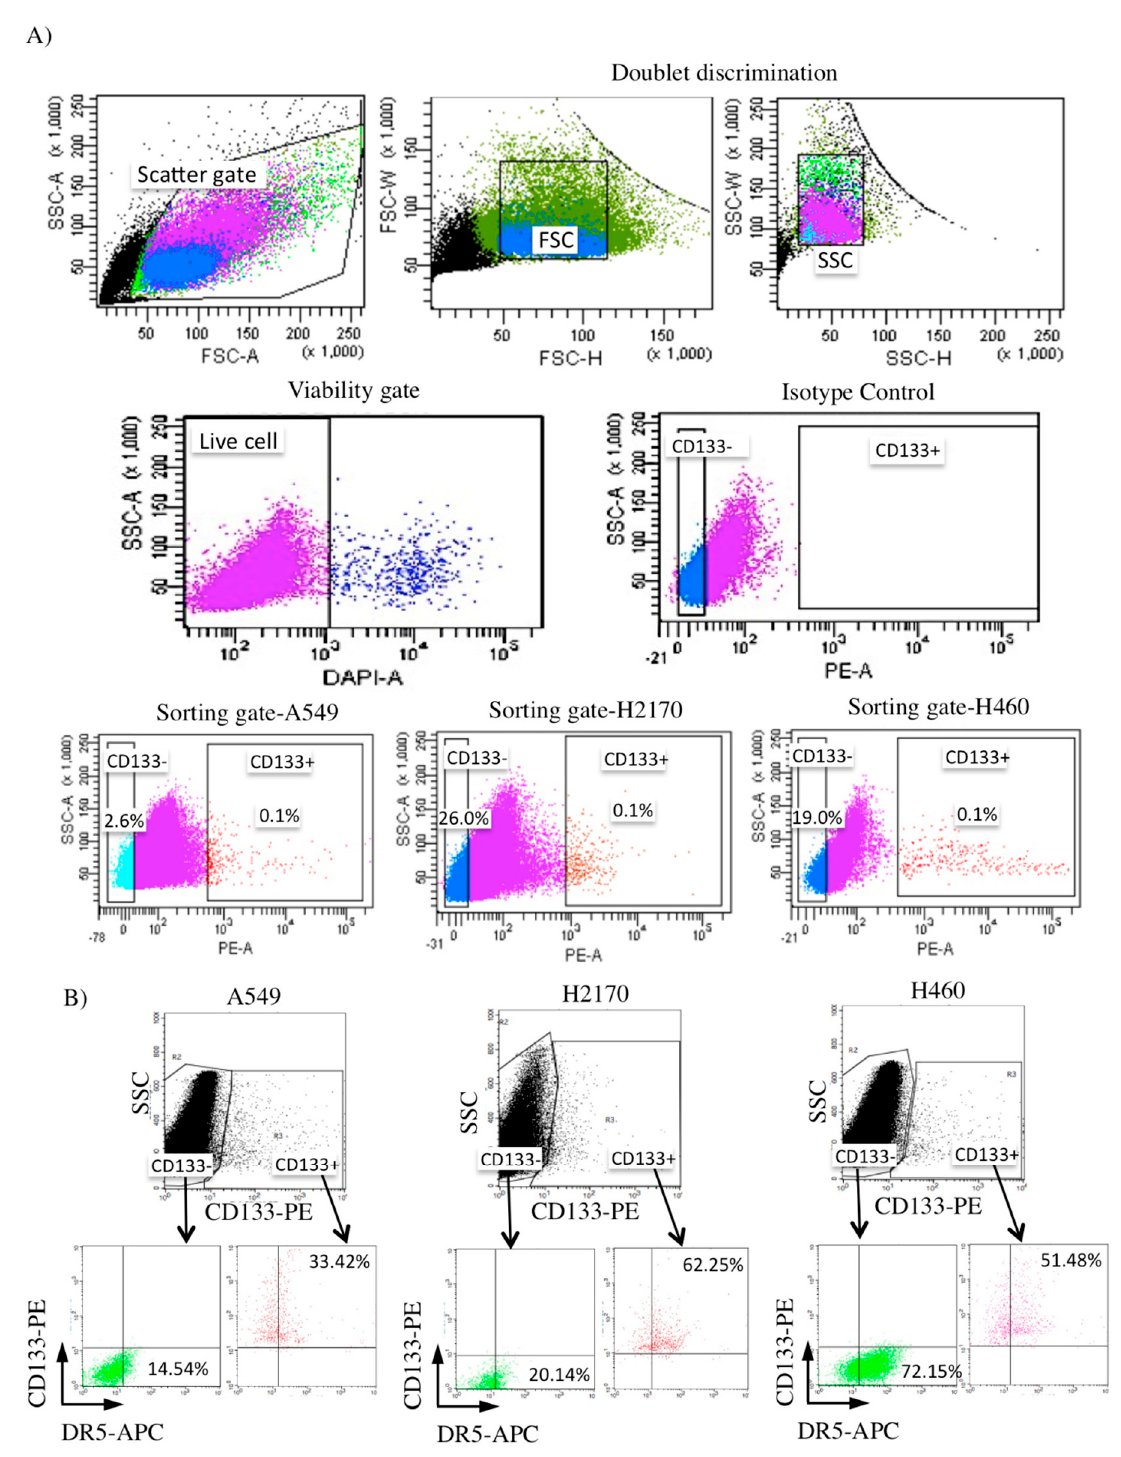
Figure 3. Flow cytometry analysis of CD133+ NSCLC-derived cancer stem cells (CSCs) and their TRAIL receptor expression. ( A ) Cell debris and doublets were discriminated, and dead cells were excluded [(DAPI/4 ′ ,6-diamidino-2-phenylindole) negative; shown by the first four panels], followed by isolation of the CD133 + population in NSCLC cell lines (A549, H2170, and H460) in the lower panels. ( B ) Both CD133 + CSCs of H2170 and H460 expressed a high level of TRAIL cognate receptor (DR5), consistent with their sensitivity to TRAIL.